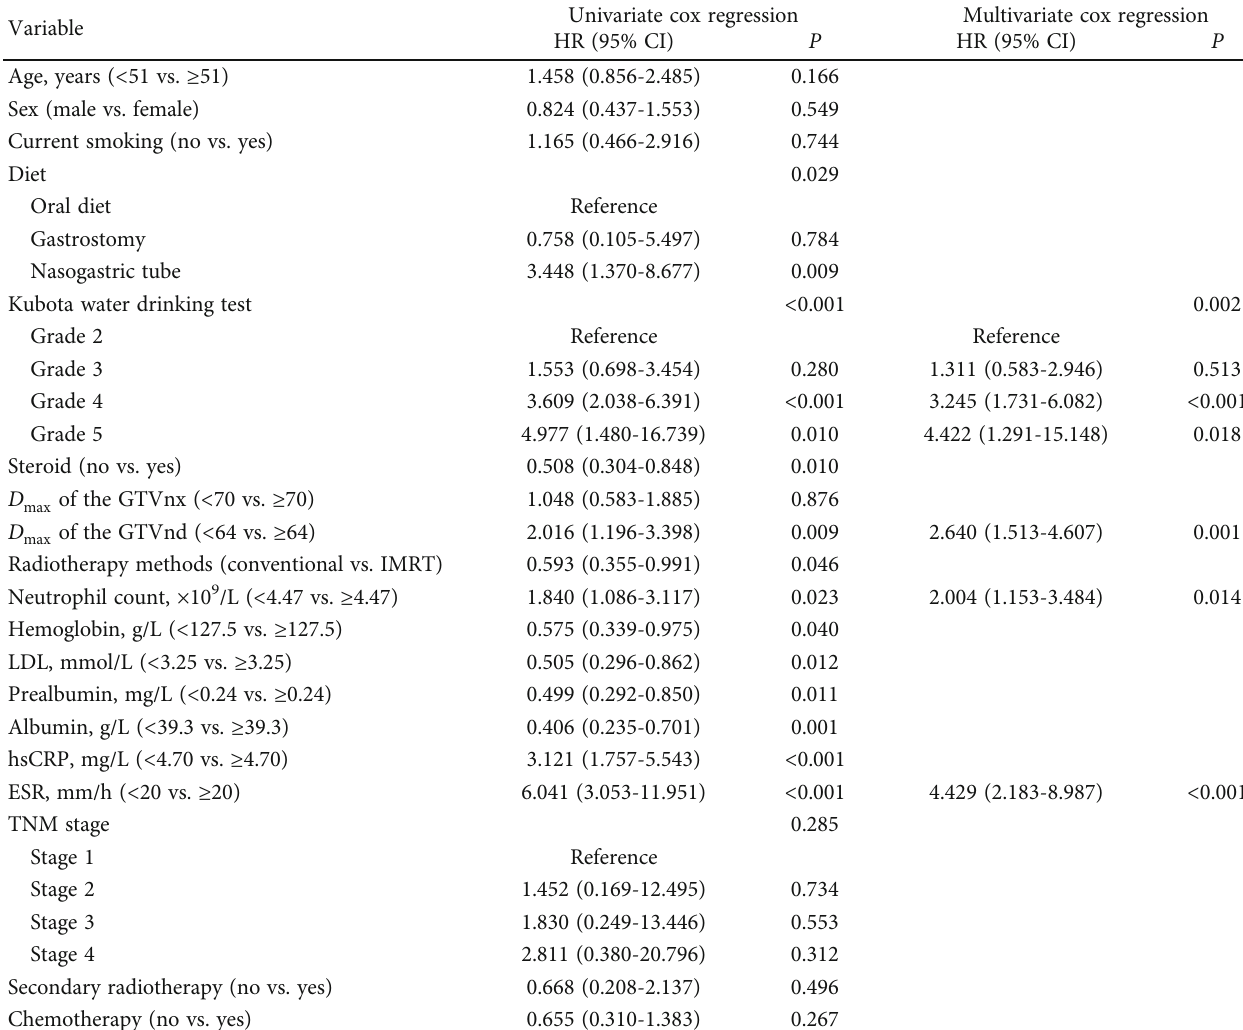
Table 2: Risk factors for radiation-associated aspiration